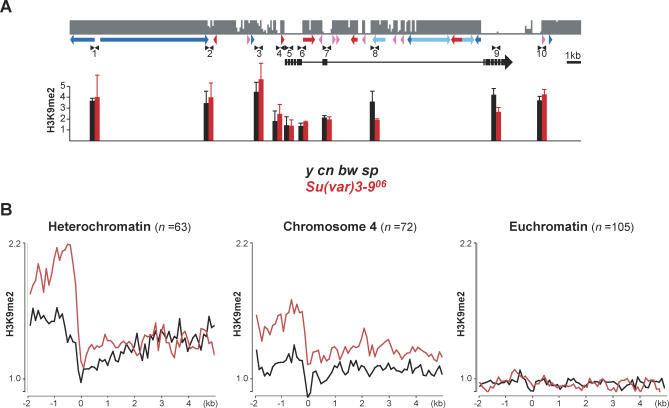
Comparison of H3K9me2 Profiles in Wild-type and Su(var)3–906 Embryos(A) The bar graph compares the H3K9me2 enrichment factors in the light gene of y; cn bw sp (black) and Su(var)3–906 (red) embryos based on three and two trials, respectively. Symbols are the same as in Figure 1.(B) Comparison of the average H3K9me2 profile of heterochromatic genes (n = 63), Chromosome 4 genes (n = 72), and euchromatic genes (n = 105) in the two genotypes, plotted as described for Figure 4B.